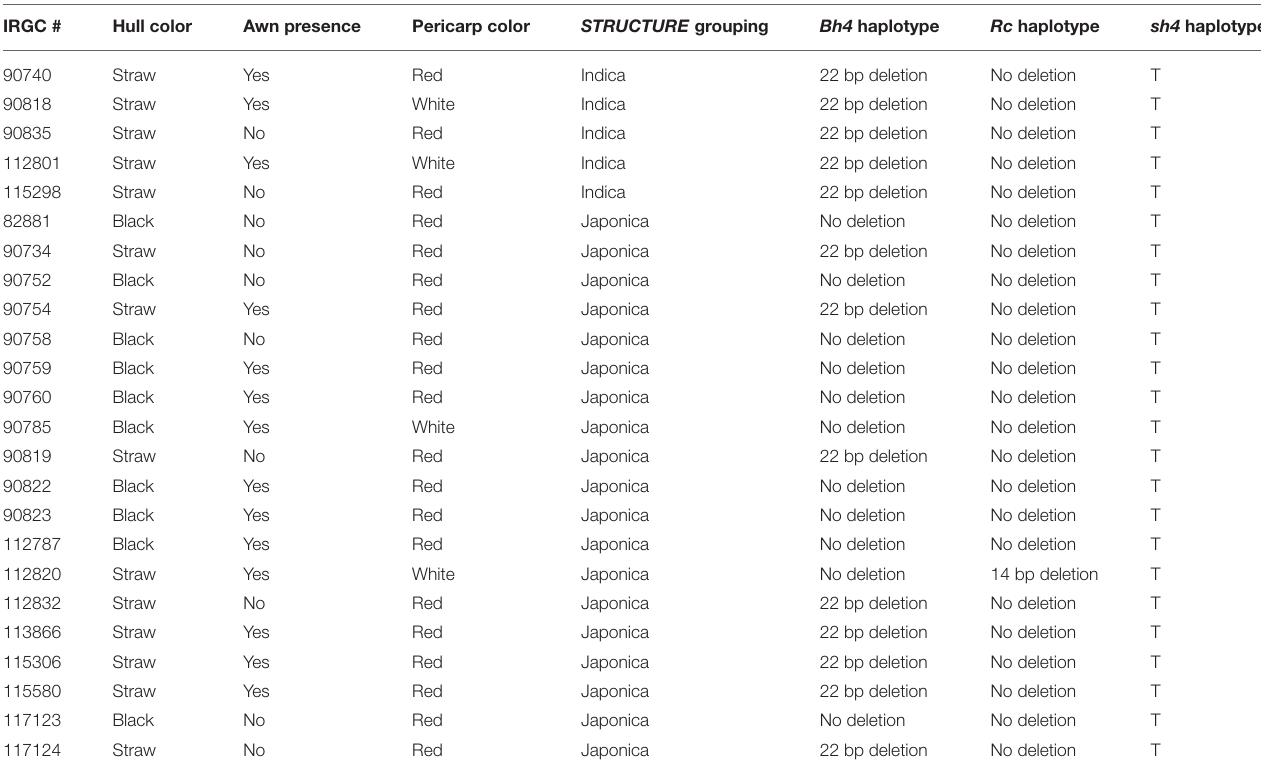
TABLE 1 | Korean Weedy Rice Accession Phenotypes and Haplotypes. IRGC # Hull